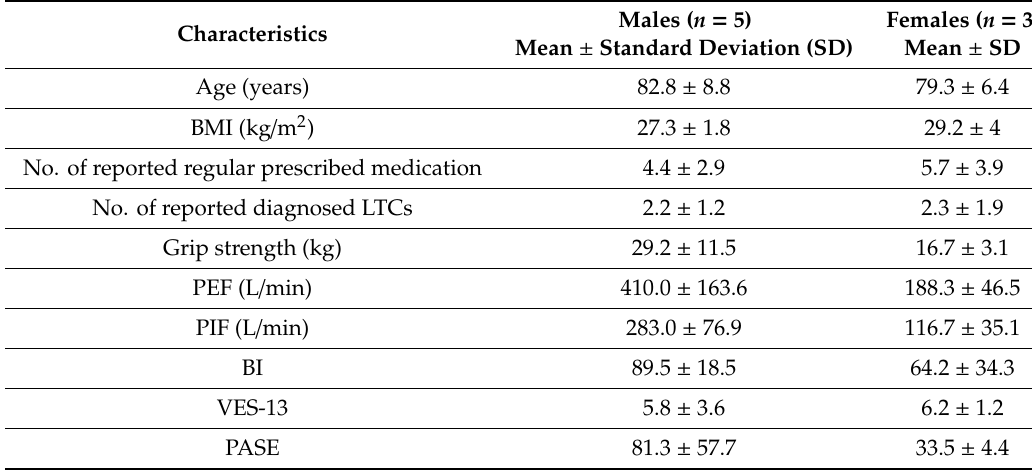
Table 1. Summary baseline characteristics of